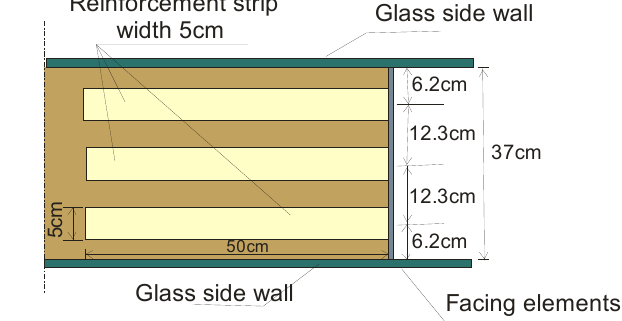
Figure 6. Cross-section of the RS model ( a ); layout of reinforcing strips ( b ).